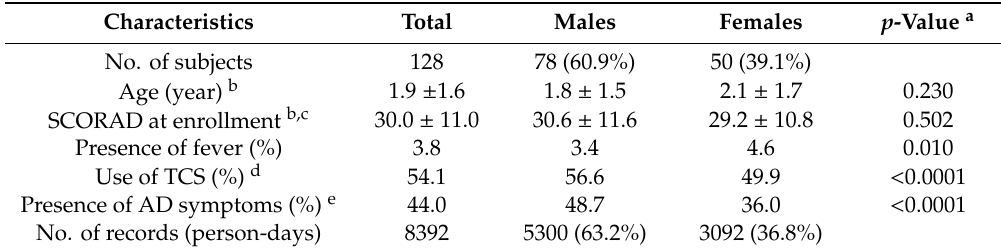
Table 1. The characteristics of the study